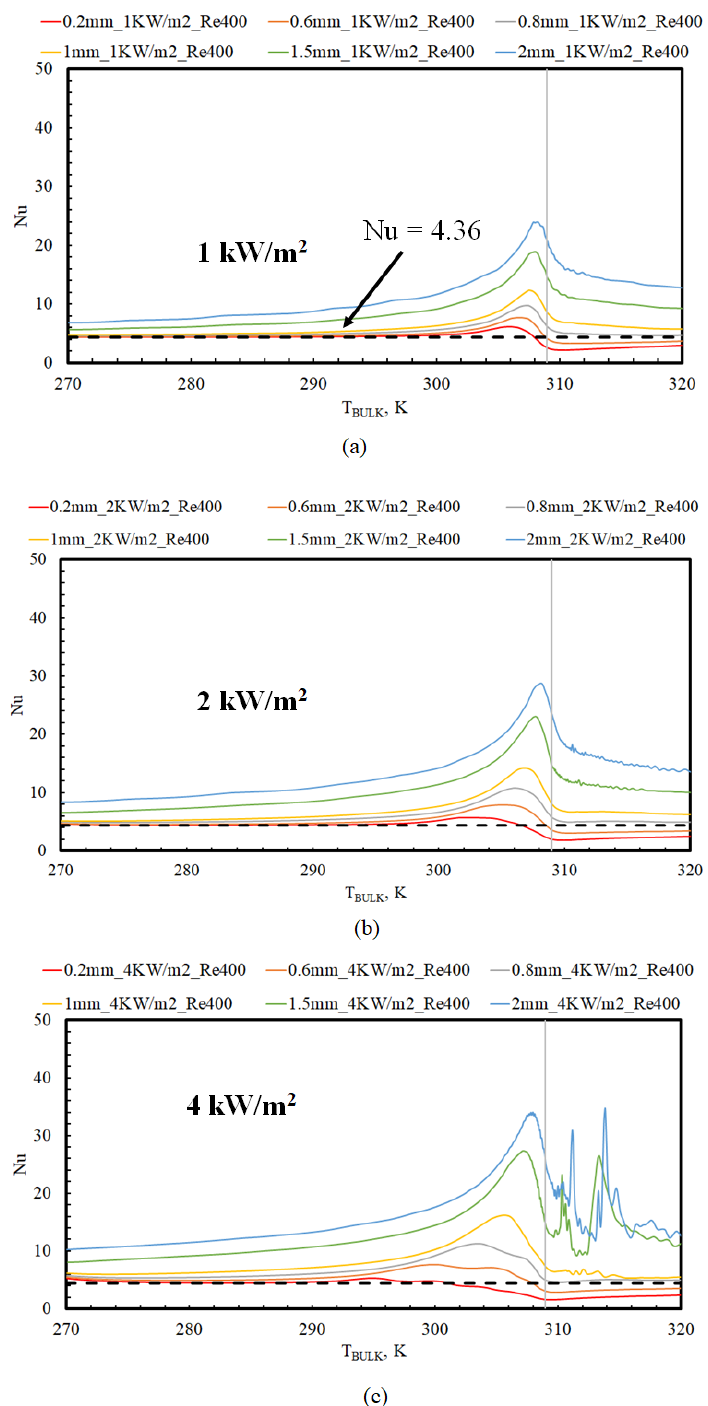
Figure 3. Nu versus bulk temperature (T BULK ) (Re 400) at different tube diameters for wall heat fluxes of: ( a ) 1 kW/m 2 ; ( b ) 2 kW/m 2 ; ( c ) 4 kW/m 2 .